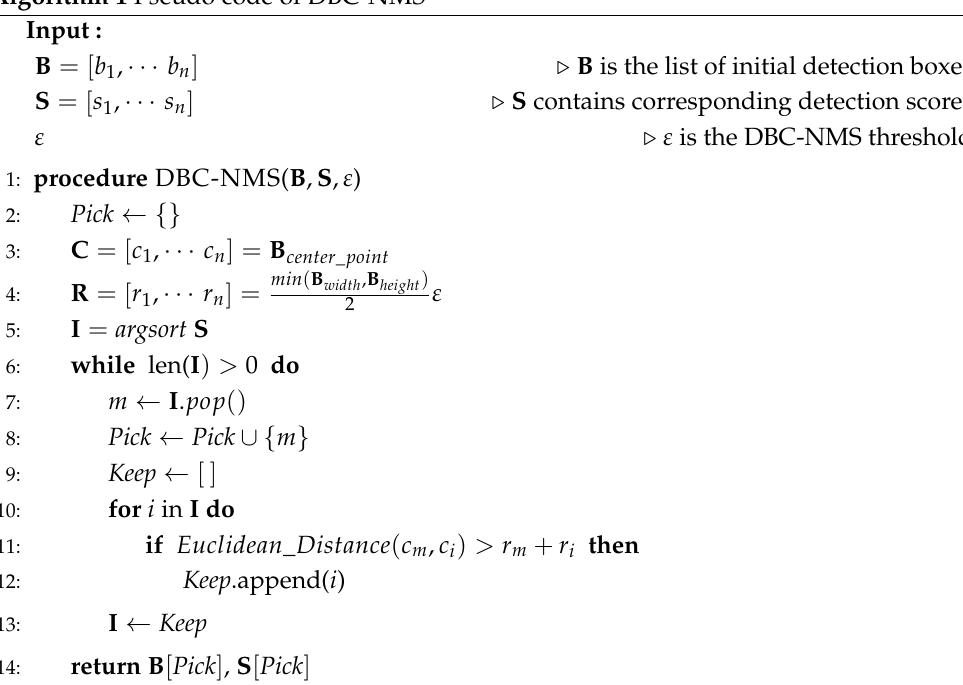
Algorithm 1 Pseudo code of DBC-NMS